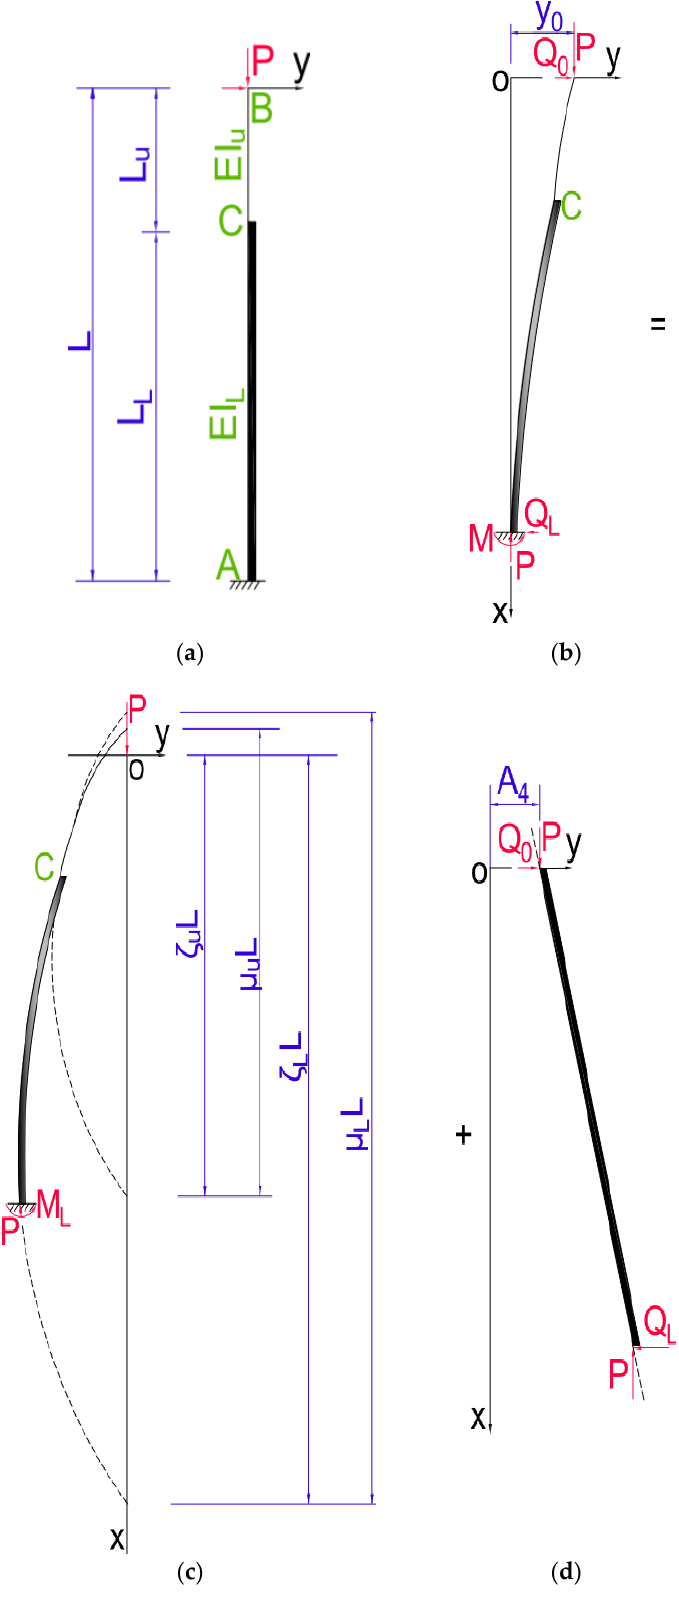
Figure 4. A decomposition diagram of the deflection of the cantilever variable stepped column bearing horizontal load at the top: ( a ) Before deformation; ( b ) after deformation; ( c ) sine curve; and ( d ) sloping straight line.